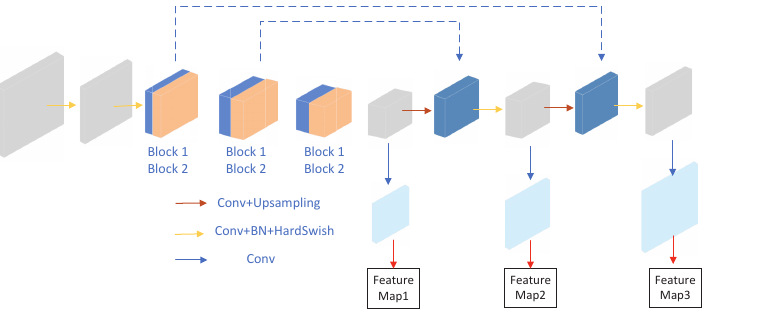
Figure 3. LF-YOLO. The backbone is based on Shufflenetv2, the head part use less BottleneckCSP module in